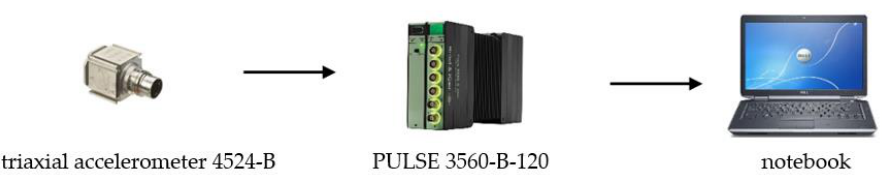
Figure 12. The measuring chain for measuring the acceleration. 10 mV · m − 1 · s − 1 , type 4524-B from company Bruel & Kjaer. The measuring unit was a